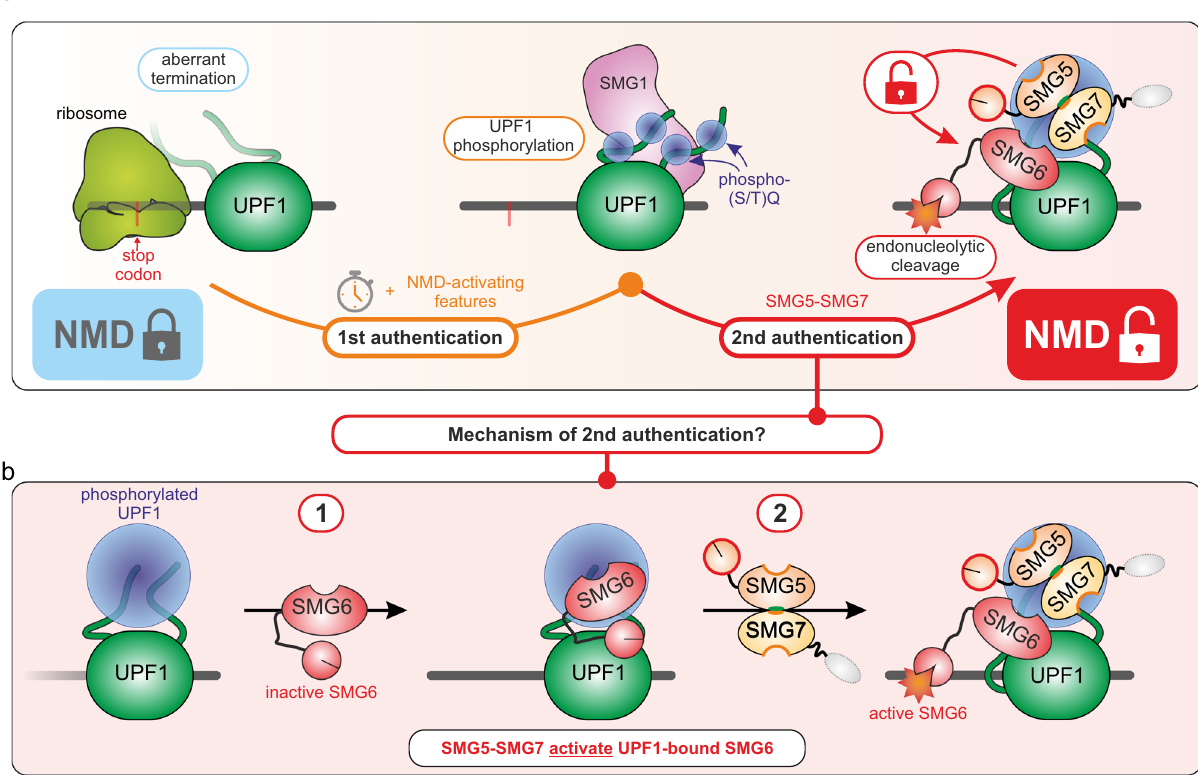
Fig. 7 Two-factor authentication model of NMD. a Overview of postulated two-factor authentication model. To grant access to the degradative activities of NMD, at least two consecutive security checks need to be passed. Aberrant translation termination in combination with an enhanced residence time of UPF1 on the mRNA and NMD-activating features (e.g., the presence of a downstream EJC) lead to increasing UPF1 phosphorylation by SMG1 (1st authentication step). Suf fi ciently phosphorylated UPF1 (p-UPF1) leads to the recruitment of SMG5-SMG7 and consequently enables the endonucleolytic activity of SMG6 (2nd authentication step). Domains and functions of SMG5 and SMG7 required to support NMD are indicated (green = low importance, orange = medium, red = high). b Hypothesis for the potential mechanism of the second authentication step. According to this hypothesis, SMG6 can be bound to p-UPF1 before SMG5-SMG7. The role of SMG5-SMG7 in NMD would be the activation of p-UPF1-bound